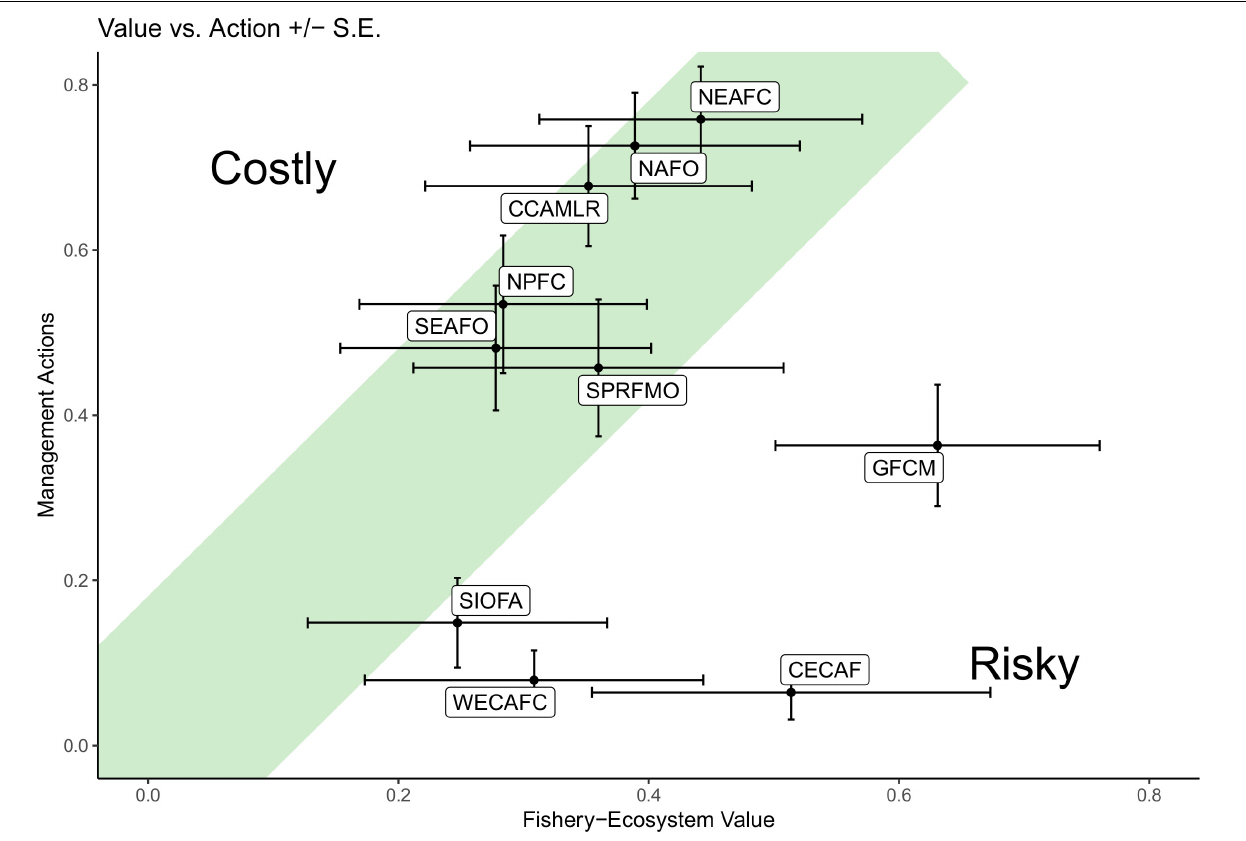
FIGURE 4 | Comparisons between the “fishery-ecosystem value” of each organization’s area of competence and its historic activity. Green area represents an idealized, though arbitrary, optimal relationship between action and value ( Figure 2 ). CCAMLR – Convention for the Conservation of Antarctic Marine Living Resources; CECAF – Fisheries Committee for the Eastern Central Atlantic; GFCM – General Fisheries Commission for the Mediterranean; NAFO – Northwest Atlantic Fisheries Organization; NEAFC – North-east Atlantic Fisheries Commission; NPFC – North Pacific Fisheries Commission; SEAFO – South East Atlantic